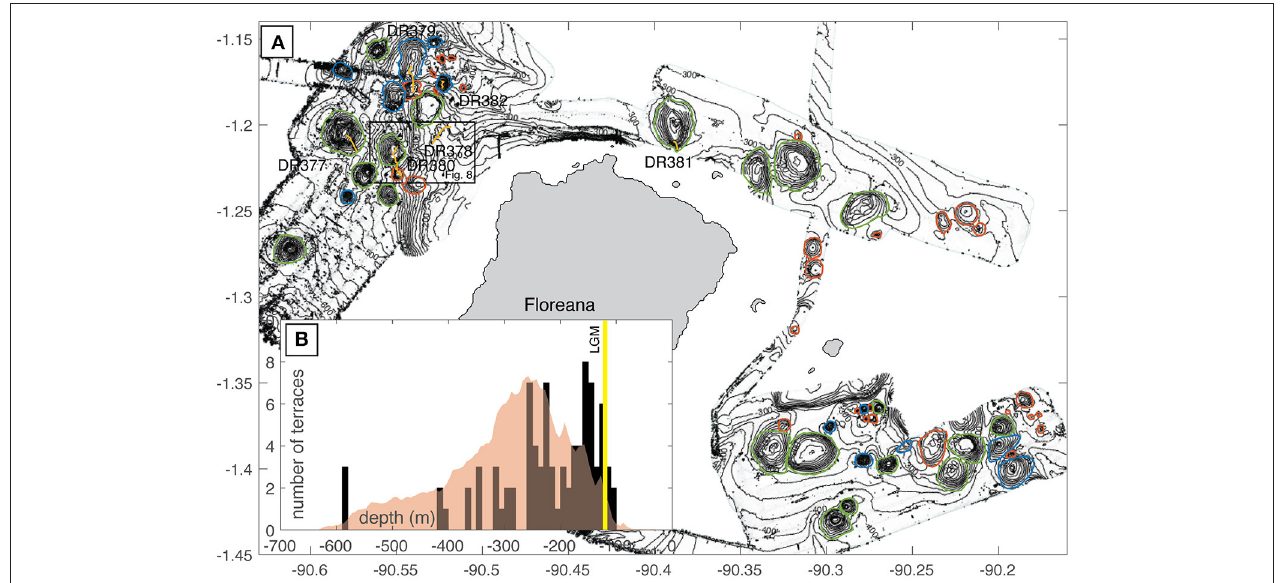
FIGURE 7 | (A) Bathymetric map of the Floreana seamounts. Gray polygons locate islands. Bathymetric contour interval is 20m. Green lines indicate footprints for seamounts > 100m of relief that have identified terraces. Blue lines indicate other mapped seamounts > 100m. Red lines indicate mapped seamounts, which are < 100m in relief. Gold lines indicate dive tracks. Location of Figure 8 is indicated by a black box. (B) Black/gray bars are histogram of depths of all identified terraces. Semi-transparent red polygon shows the probability distribution of all depths within the mapped seamount footprints. Yellow bar indicates the depth of the last glacial maximum sea-level lowstand.